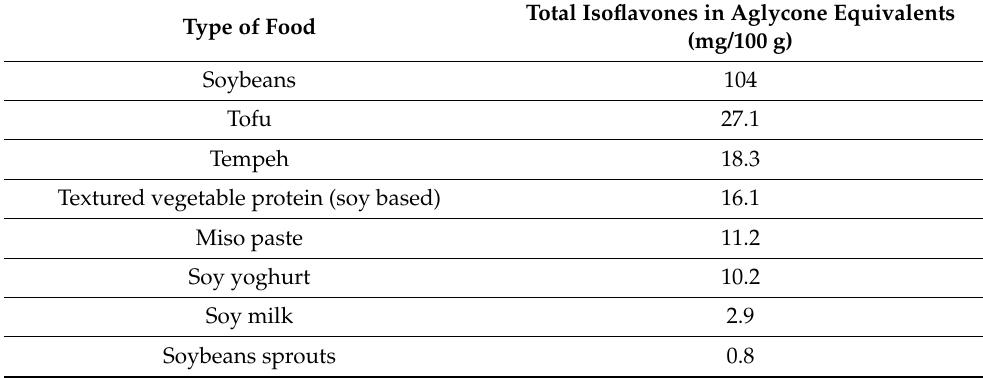
Table 2. Isoflavone contents of soy foods